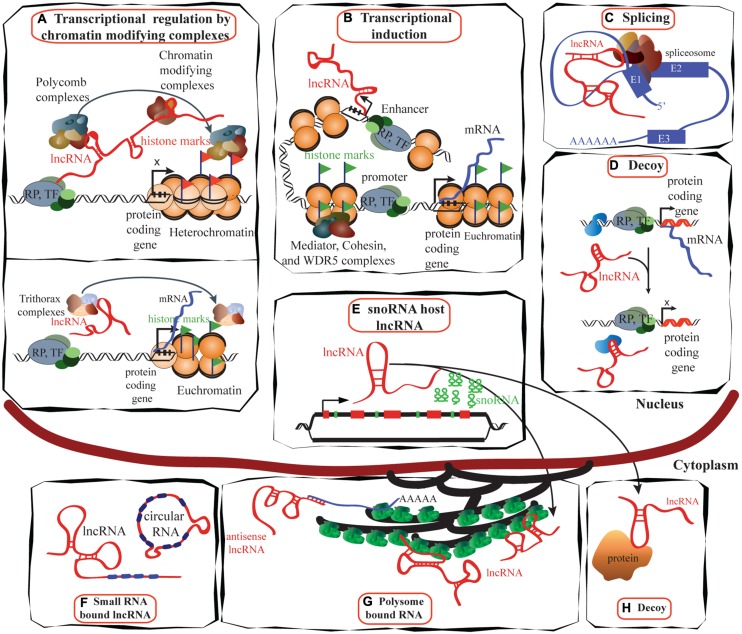
Schematic illustrating the functions of lncRNAs. (A) LncRNAs (e.g., HOTAIR) can suppress transcription by interacting with PRC1 and PRC2 complexes as well as with other chromatin modifying proteins, maintaining heterochromatin status and suppressing transcription (reviewed in Gibb et al., 2011; upper panel). Trithorax complexes also can interact with lncRNA (e.g., HOTTIP) and induce transcription (lower panel; reviewed in Jobe et al., 2012). (B) LncRNAs are proposed to be transcribed at enhancer regions and can function in the establishment and maintenance of enhancer–promoter looping and activation of gene expression (Orom and Shiekhattar, 2013). (C) LncRNAs such as MALAT1 can regulate alternative splicing by interacting with the spliceosomal machinery (Tripathi et al., 2013). (D) Specific lncRNAs are transcribed and bind to and titrate away protein factors. Decoy lncRNAs can bind to protein factors such as transcription factors and chromatin modifiers. This leads to broad changes in transcriptomes. (E) Intronic regions of many lncRNAs host snoRNAs. The snoRNAs derived from these lncRNAs remain in the nucleus while the spliced transcript can move to the cytoplasm and bind either to polysomes or to other proteins (Smith and Steitz, 1998). (F) LncRNAs can bind to miRNAs to sequester them and inactivate their repressive functions (reviewed in Gibb et al., 2011). (G) Many lncRNAs are associated with polysomes (van Heesch et al., 2014), while the mechanisms of many are yet to be identified, antisense lncRNAs such as UCHL1AS regulate the translation of associated mRNAs. (H) Decoy lncRNAs such as GAS5 are present in both in the cytoplasm and the nucleus: GAS5 translocates from the cytoplasm into the nucleus with glucocorticoid receptor in response to dexamethasone (Kino et al., 2010). TF, transcription factor; RP, RNA polymerase; E1, exon1.